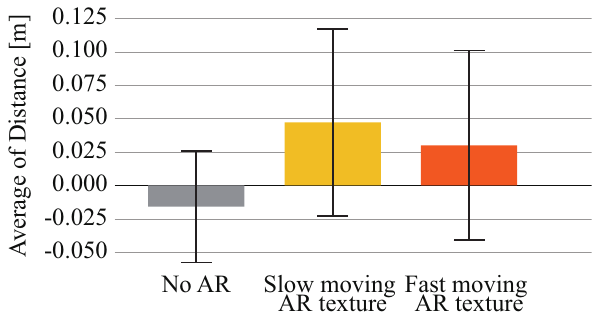
Figure 23. Results of average of distence between the goal point and the arrival point. As the results, the standard error values are large, suggesting that there are differences between individuals. The results for each individual are shown in Figure 24. The difference in distance between the results without AR display and with AR display is also shown in Figure 25. Seven of the nine participants thought that they were being swept to the right. However, as can be seen in Figures 24 and 25, only some of the participants were moving in the right direction. We thought that the faster the stripes moved, the more they moved to the right, but only Participant-B showed such a result. Participants D, G, and I commented that they did not move to the right because they were about to be swept to the right, so they tried to correct to the left. In fact, these three participants did move to the left.